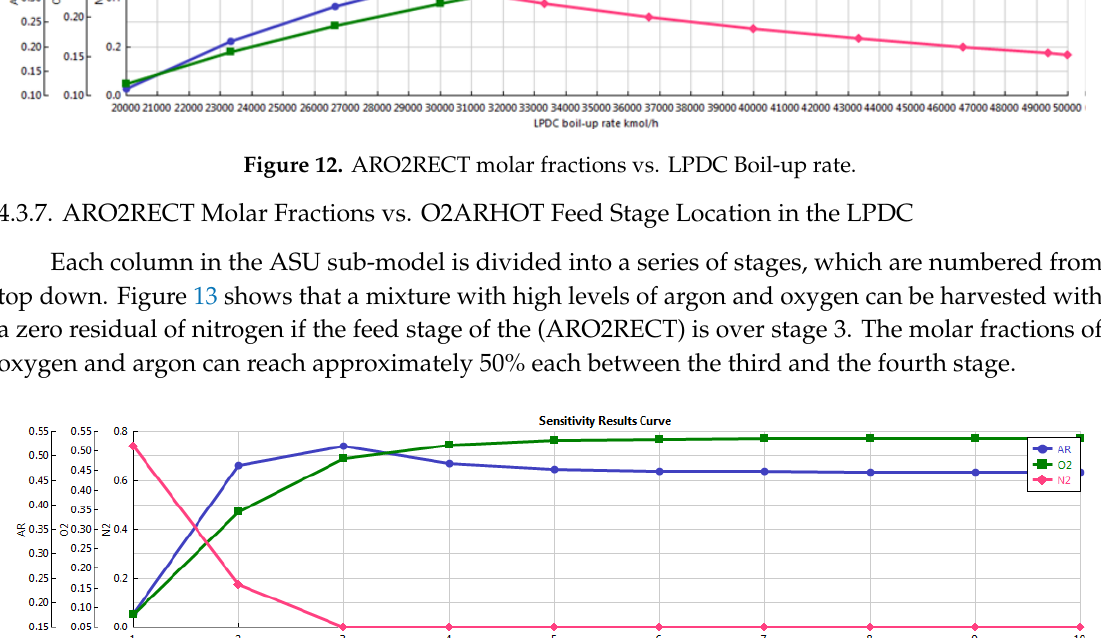
Figure 13. ARO2RECT molar fractions vs O2ARHOT Feed stage location in the LPDC.